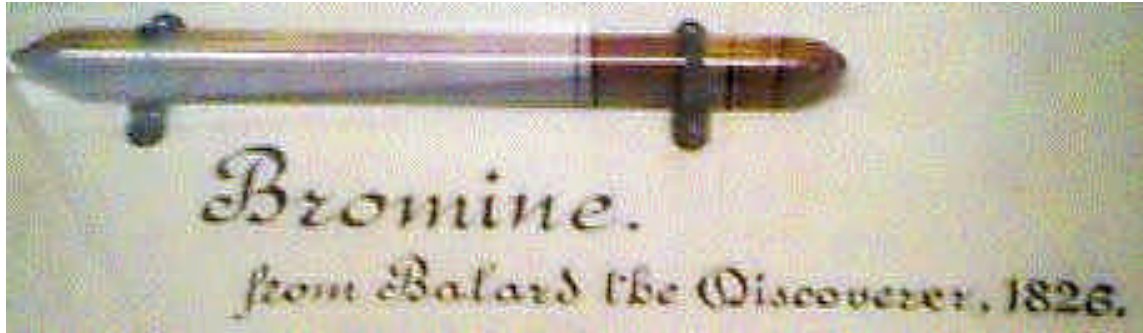
Figure 2. Ballard's bromine.